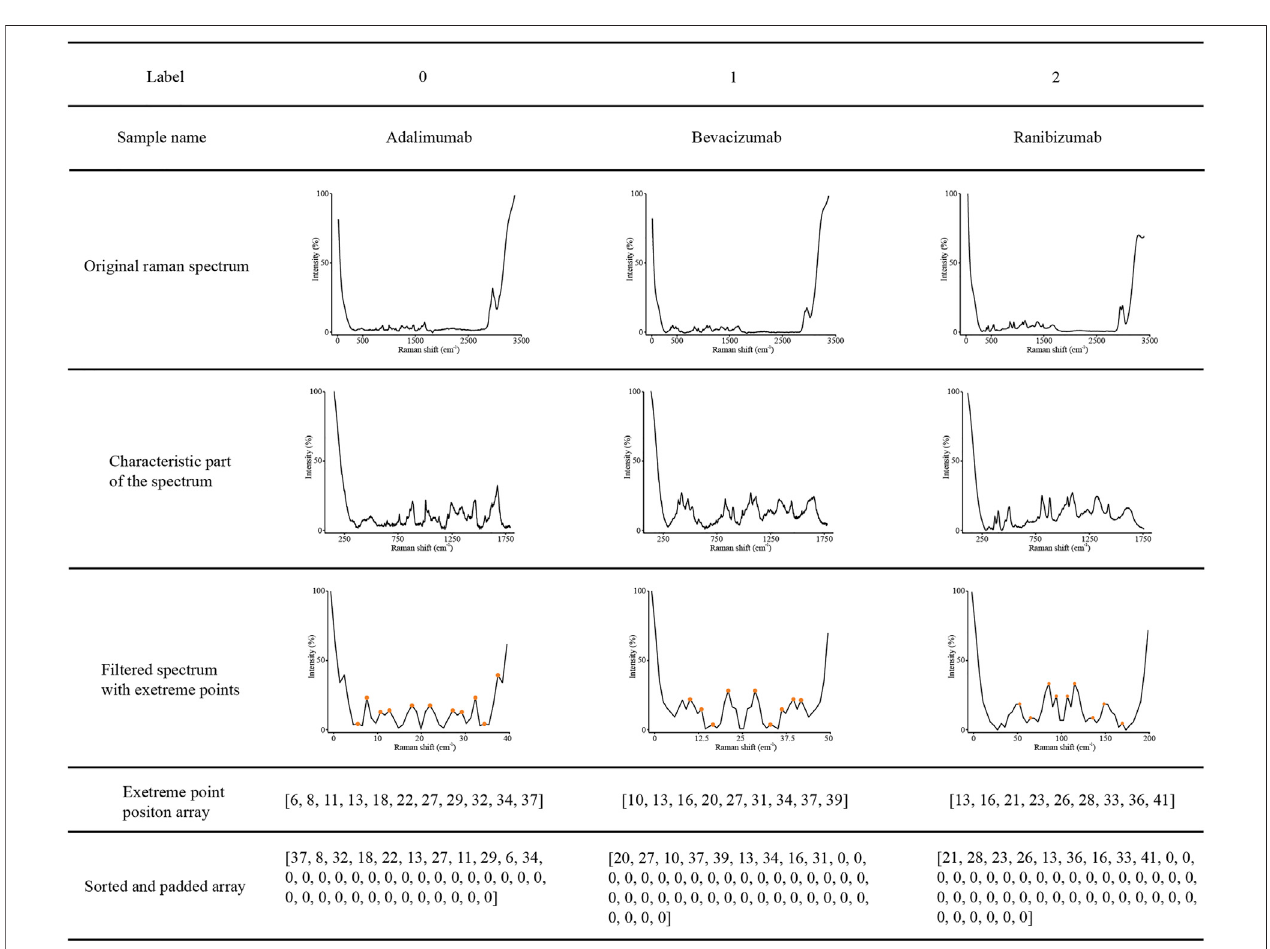
FIGURE 4 | Visualization examples of the original Raman spectra, characteristic region of Raman spectra, characteristic region converted by extreme point transformation, sorted, and padded array of adalimumab, bevacizumab and ranibizumab.